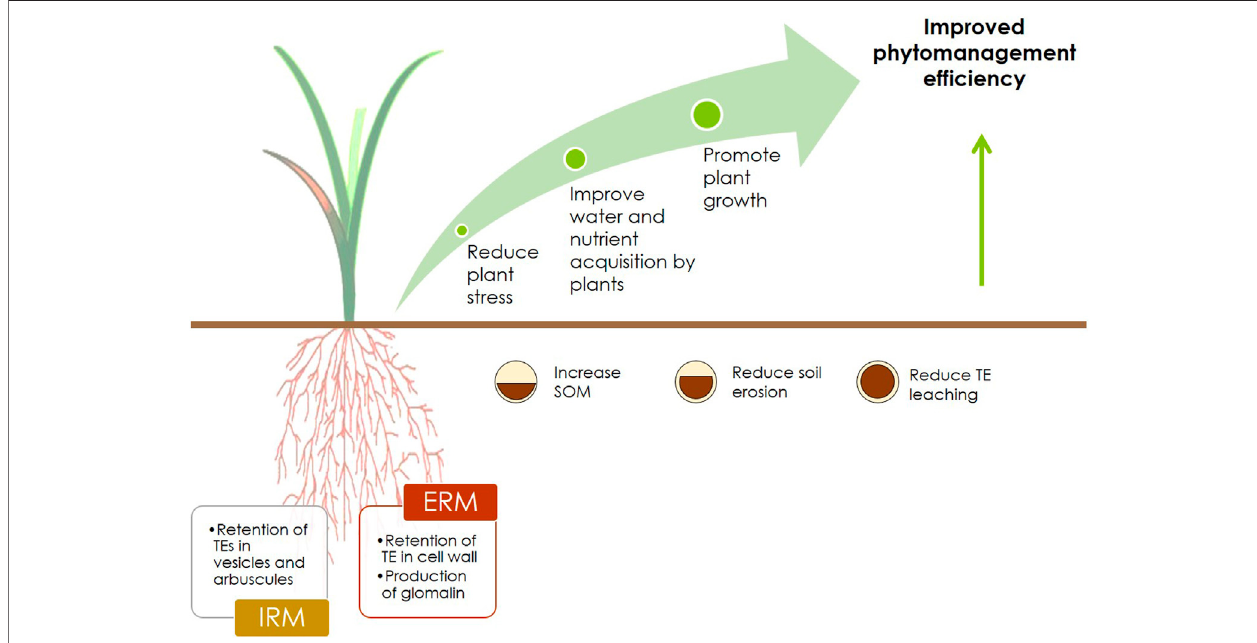
FIGURE 2 | Effects of AMF inoculation in plant development grown under TE-contaminated soils.